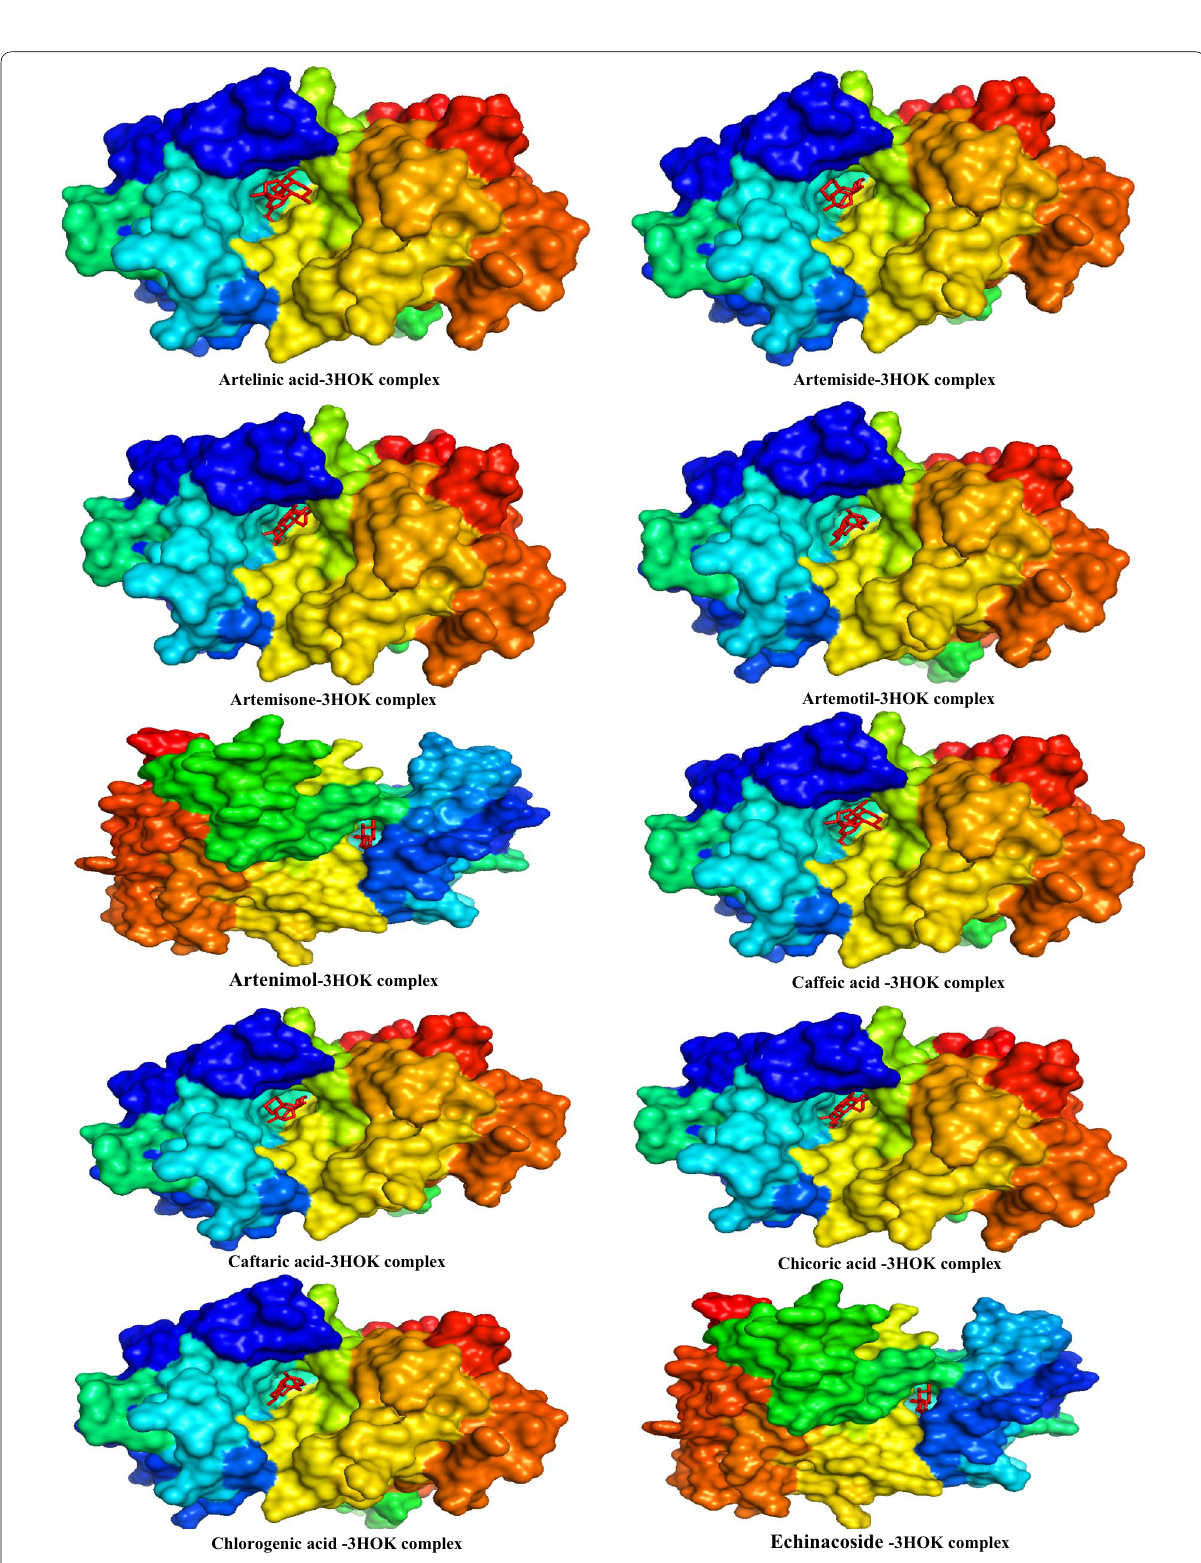
Fig. 9 Three‑dimensional structure of all studied ligands docked inside 3HOK